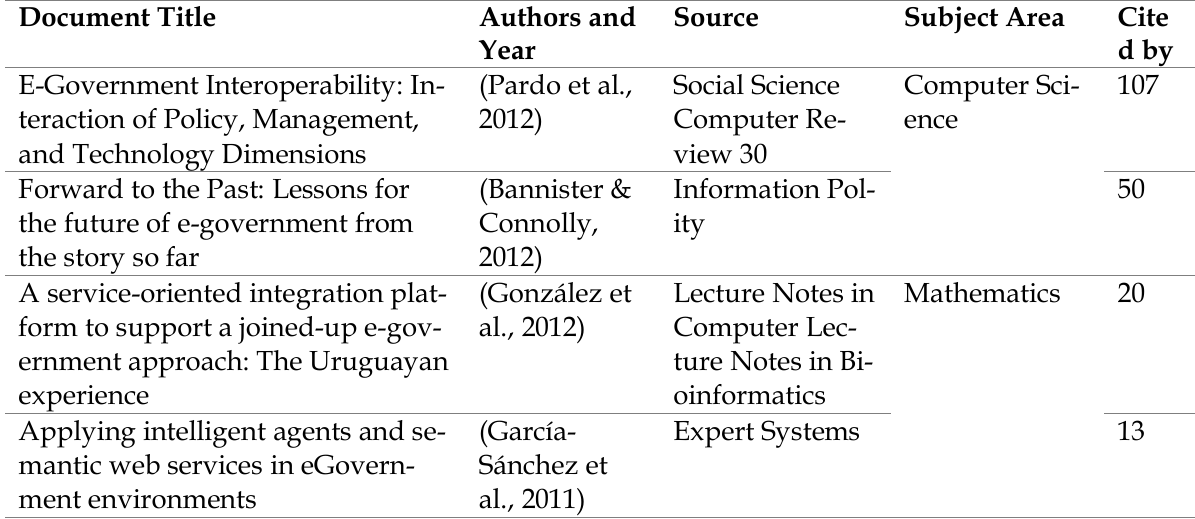
Table 3: Highest Citation by Subject Area. Source: Scopus